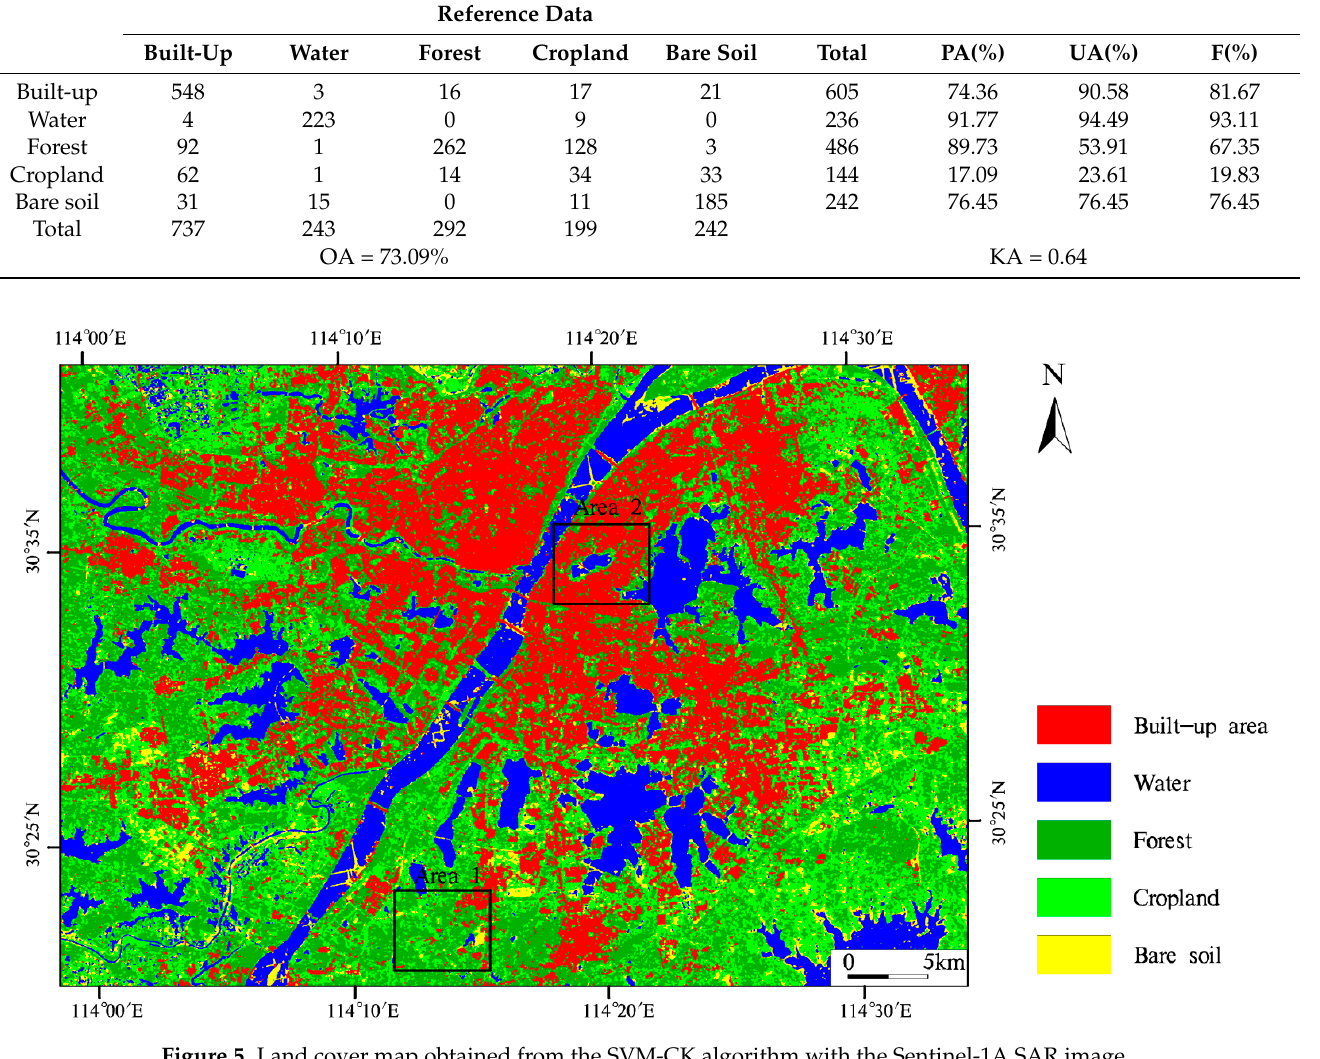
Table 3. Confusion matrix of the classification results using only the Sentinel-1A SAR data.